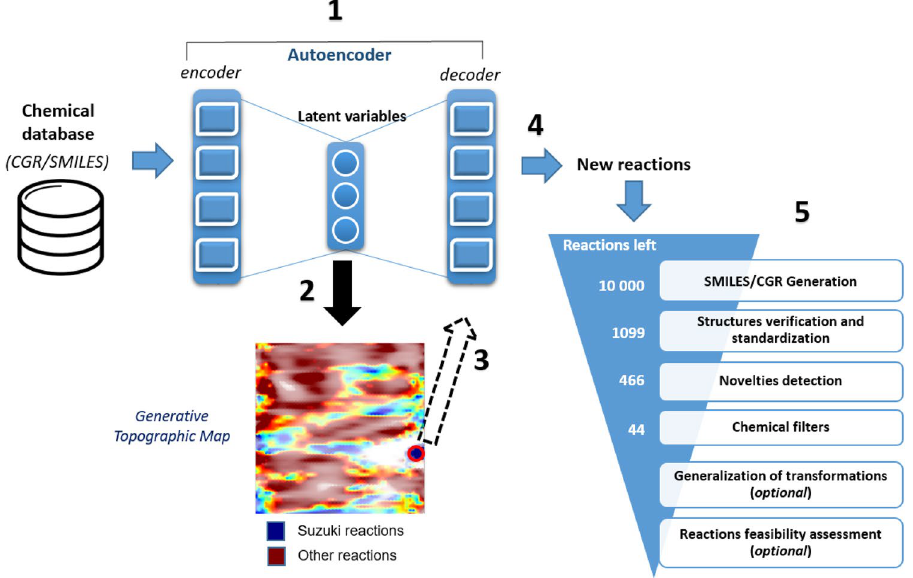
Figure 2. Modeling workflow for generation of new reactions consists of five main steps: (1) training sequence- to-sequence autoencoder on the USPTO database of chemical reactions; (2) building of Generative Topographic Map (GTM) using the autoencoder latent variables and preparation of GTM class landscape; (3) selecting on GTM a zone populated to Suzuki coupling reactions and identification of related autoencoder latent vectors; (4) sampling from the autoencoder latent space and generation of new reactions; and, (5) post-processing step. On the Generative Topographic Map, larger transparency levels correspond to lower density. The color code renders the (binary: Suzuki vs Other) reaction class distribution. Thus, zones in dark blue are exclusively populated by Suzuki reactions, zones in dark red are exclusively populated by other types of reactions; while intermediate colors correspond to reaction space areas hosting both categories, in various ratios. The red circle indicates the zone from which virtual Suzuki reactions were